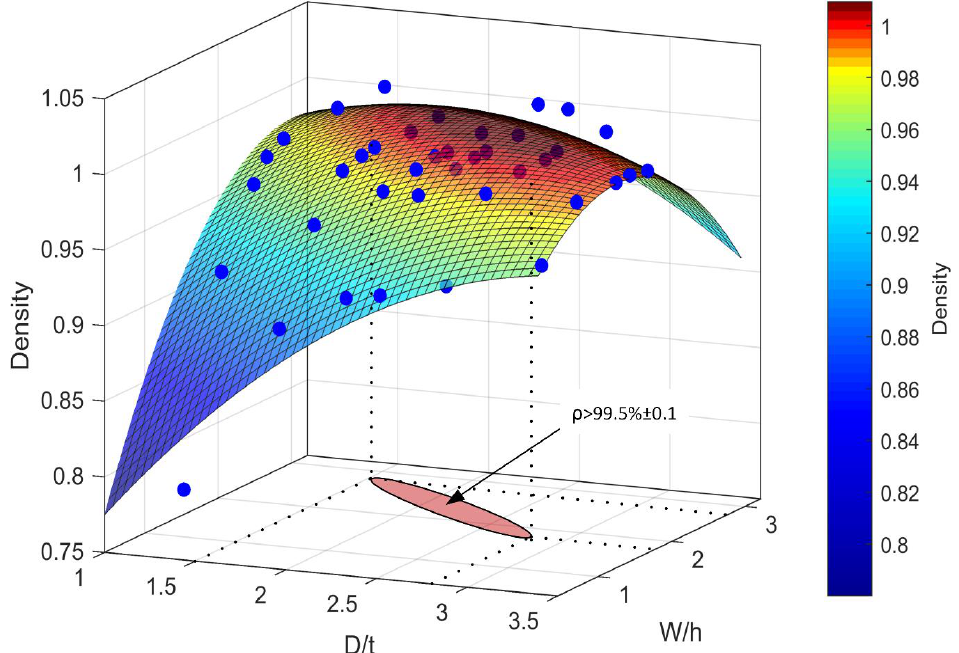
Figure 3. Density of the printed coupons as a function of the D/t and W/h ratios; the calculated D/t - W/h area corresponds to the measured density of the printed material exceeding 99.5 0.1%.